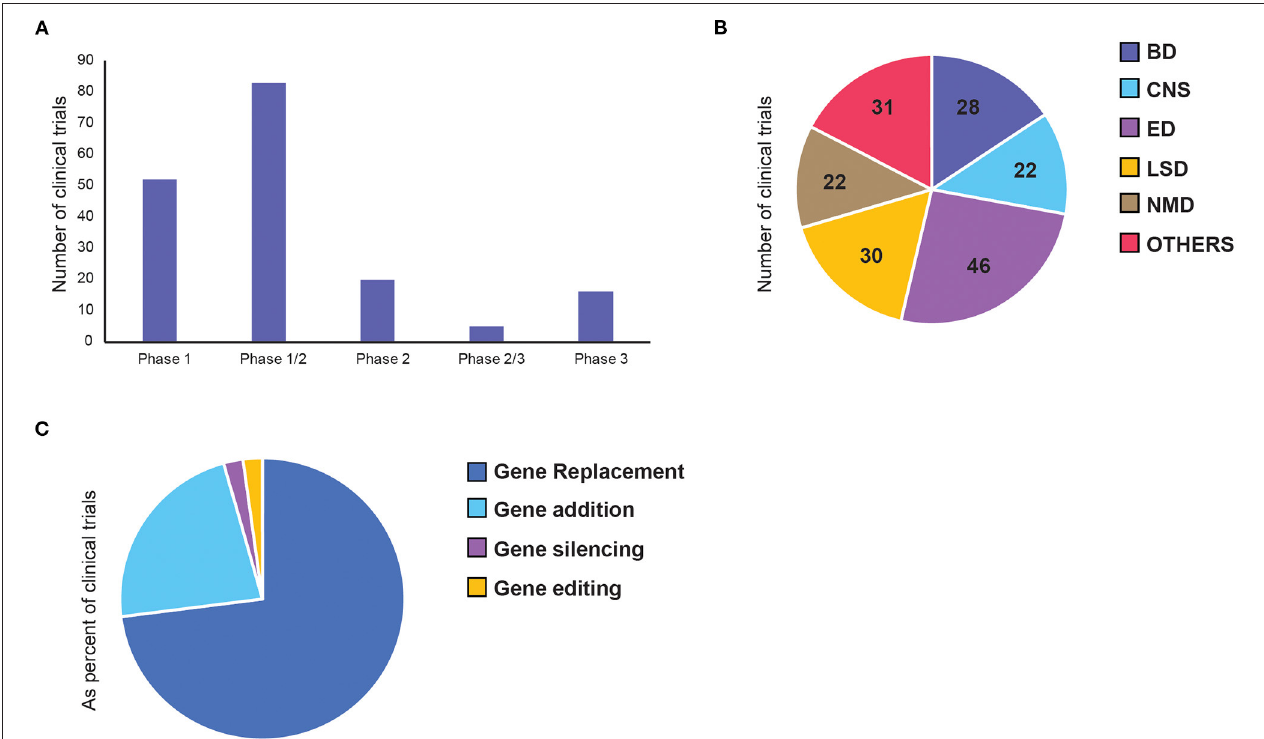
FIGURE 3 | Distribution of adeno-associated virus (AAV)-mediated gene therapy in clinical trials. Each panel represents number of clinical trials by (A) current status of the clinical phase, (B) therapeutic area, and (C) gene therapy approaches. BD, Blood disorders; CNS, Central Nervous System; ED, Eye Disorders; LSD, Lysosomal storage disorders; NMD, Neuromuscular